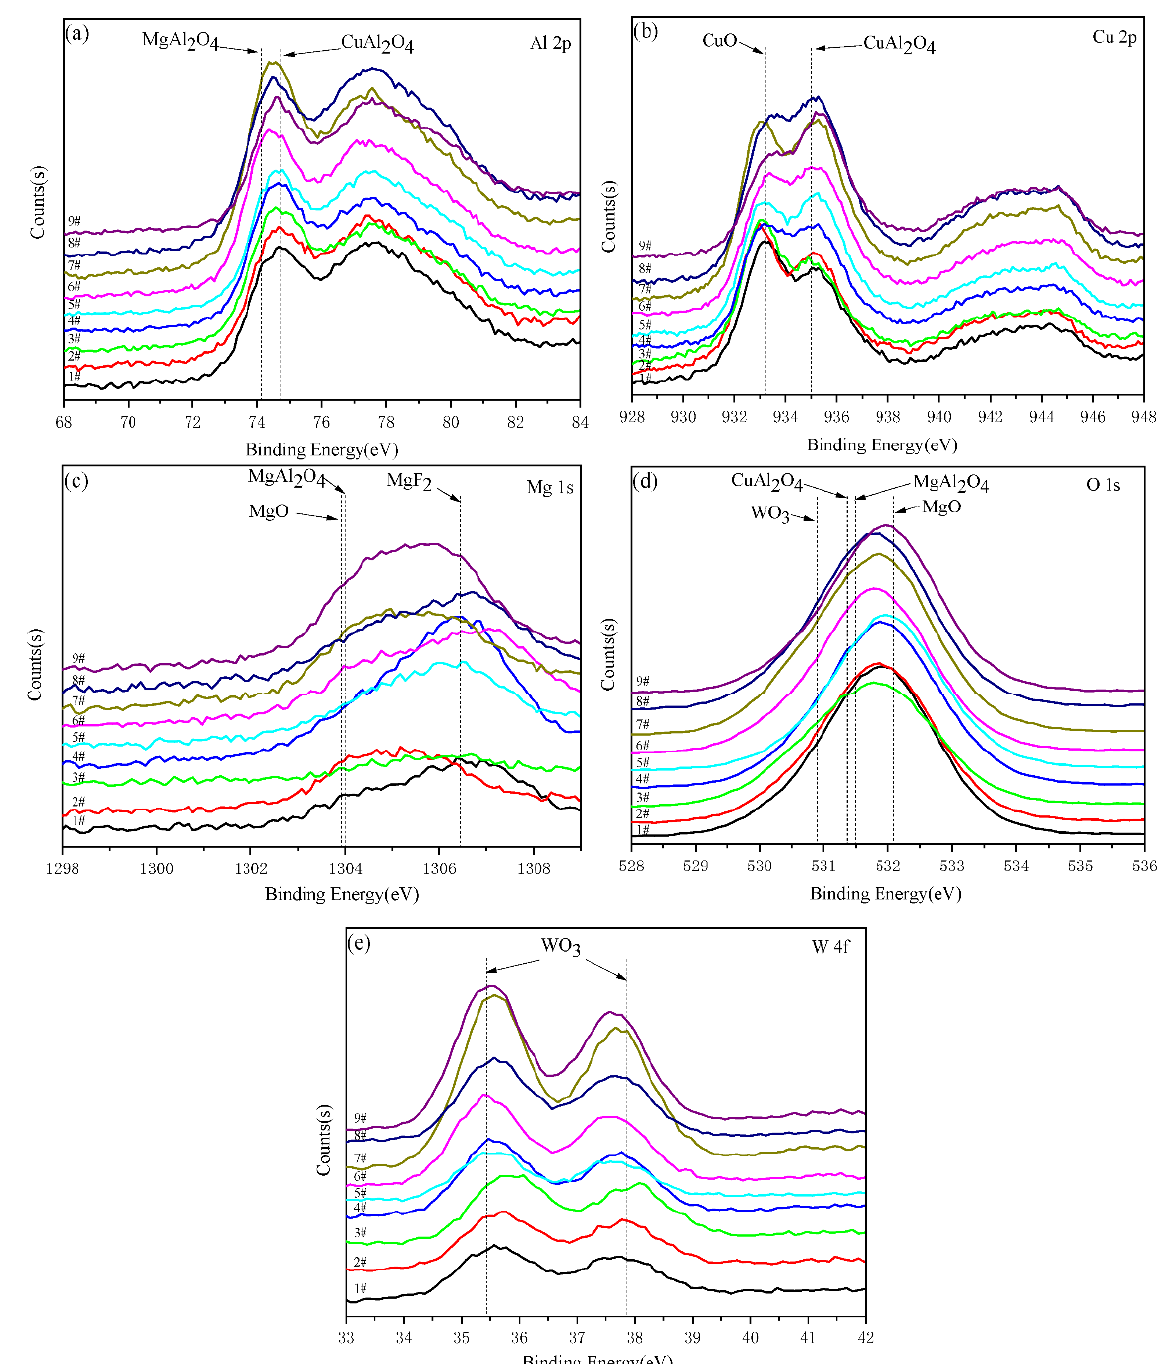
Figure 8. XPS high-resolution spectra of Al 2p, Cu 2p, Mg 1s, O 1s and W 4f of black MAO coating samples 1 # –9 # , ( a ) Al 2p; ( b ) Cu 2p; ( c ) Mg 1s; ( d ) O 1s; ( e ) W 4f.